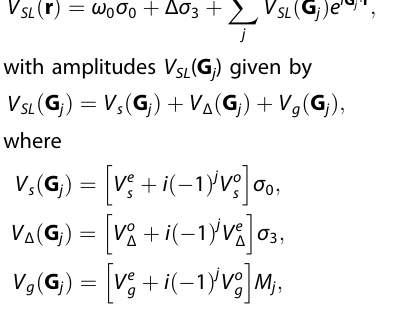
full TB model (black line) and the fi tting with a continuum model (red line) using our estimated set of parameters which agree qualitatively with the TB calculations (see Supplementary Note 8).